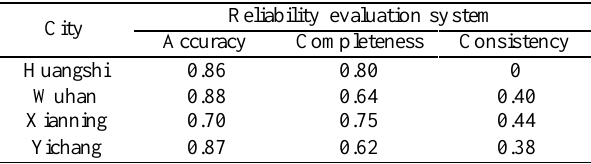
Table 11. Reliability evaluation results of the summer lightning activities for the four cities By analyzing the reliability evaluation results of the summer lightning activities in Huangshi, Wuhan, Xianning, and Yichang, the following conclusions were